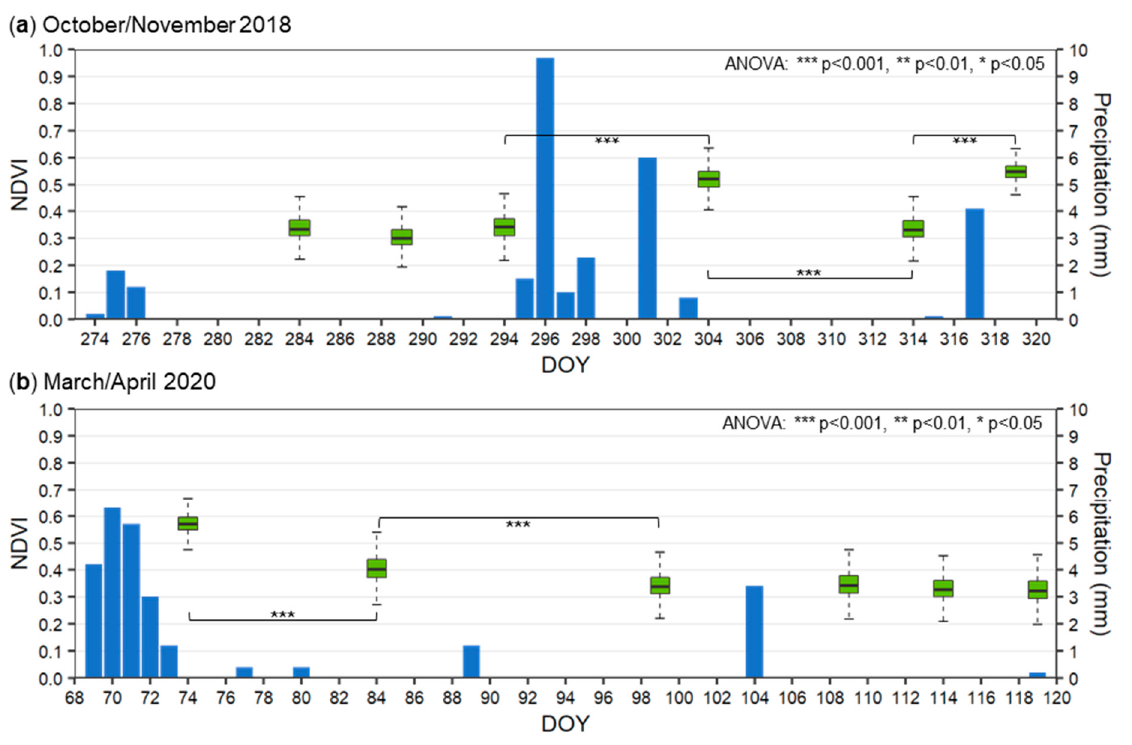
Figure 7. Sentinel-2-based NDVI values for the class ‘biological soil crusts’ (BSCs) for each available acquisition (green boxplots) and the daily precipitation sum (blue bars) measured at the Lieberose weather station (ID 2997) for the two example periods from day-of-year (DOY) 273 to 321 during Oct./Nov. 2018 ( a ) and DOY 68 to 120 in March/April 2020 ( b ). The significance of the difference between dry and wet events was determined using one-way ANOVA. The asterisks indicate the level of significance (*** p < 0.001, ** p < 0.01, * p < 0.05). Table 3. Descriptive statistics of the Sentinel-2-based NDVI observations for the two example periods from day-of-year (DOY) 273 to 321 in October/November 2018 and from DOY 68 to 120 in March/April 2020 for each land cover class separated for dry and wet conditions. Hereby, the NDVI values for DOY 84 in 2020 were omitted, as they represent intermediate conditions.